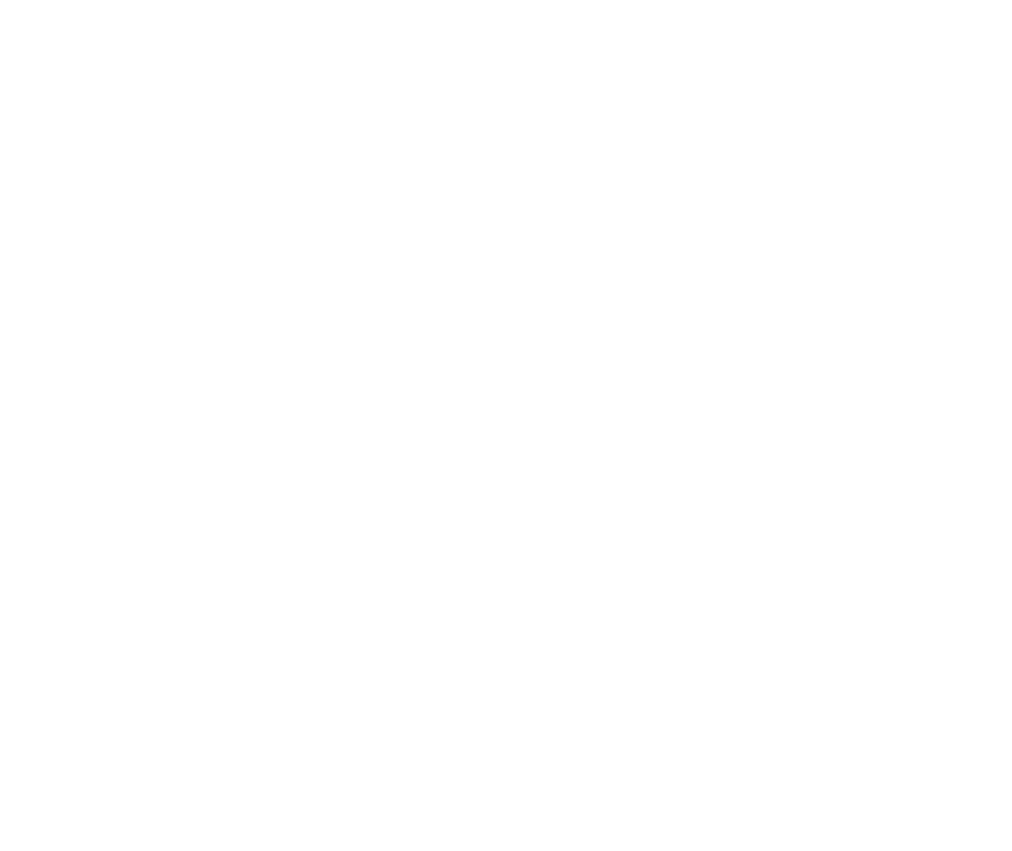
Figure 1 Perspective view of the title compound with the atom numbering scheme; displacement ellipsoids are at the 50% probability level; H atoms are drawn as small spheres of arbitrary radii. Hydrogen bonds are drawn as dashed lines. Symmetry operator for generating equivalent atoms: 1 - x , 1 - y , 1 - z